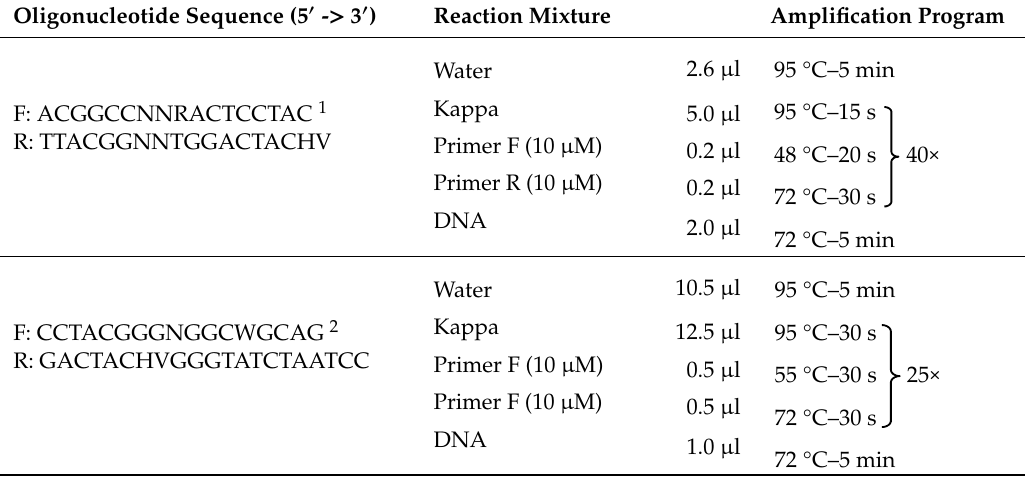
Table 1. Sequences of primers, reaction mixture, and amplification programme used in the study.